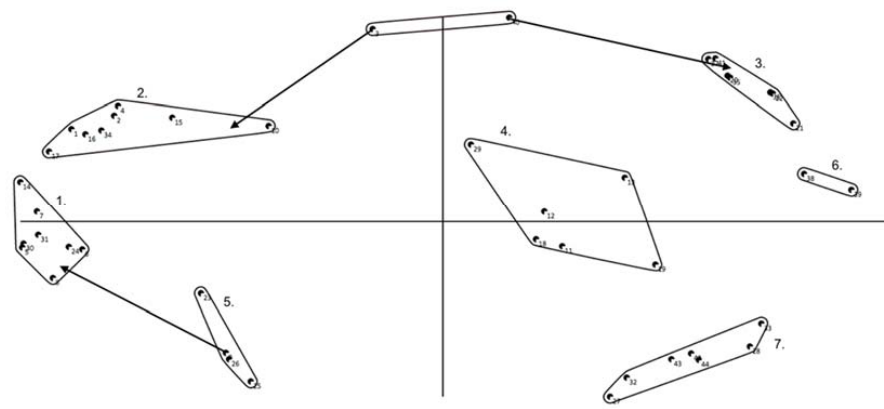
Figure 2. Concept map parents (convenience sample). Note that points, i.e., statements, sorted more often together appear closer to each other, and statements never/rarely sorted together appear widely separated.; Arrows indicate a statement is reallocated by researchers, circles indicate a new cluster is created by researchers as a result of reallocation of statements. Cluster 1: My child sits because it is the